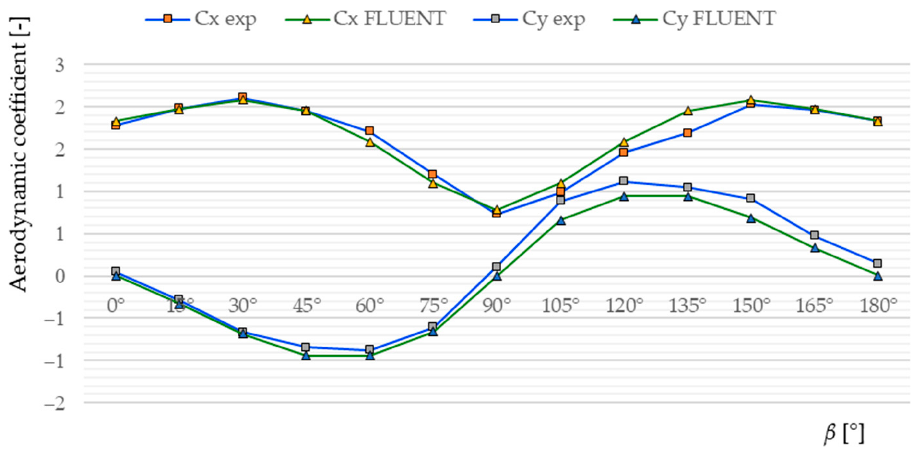
Figure 10. Comparison of the force coefficient C x and C y for the experimental and numerical results as function of angle of wind attack β in the case of configuration 1.